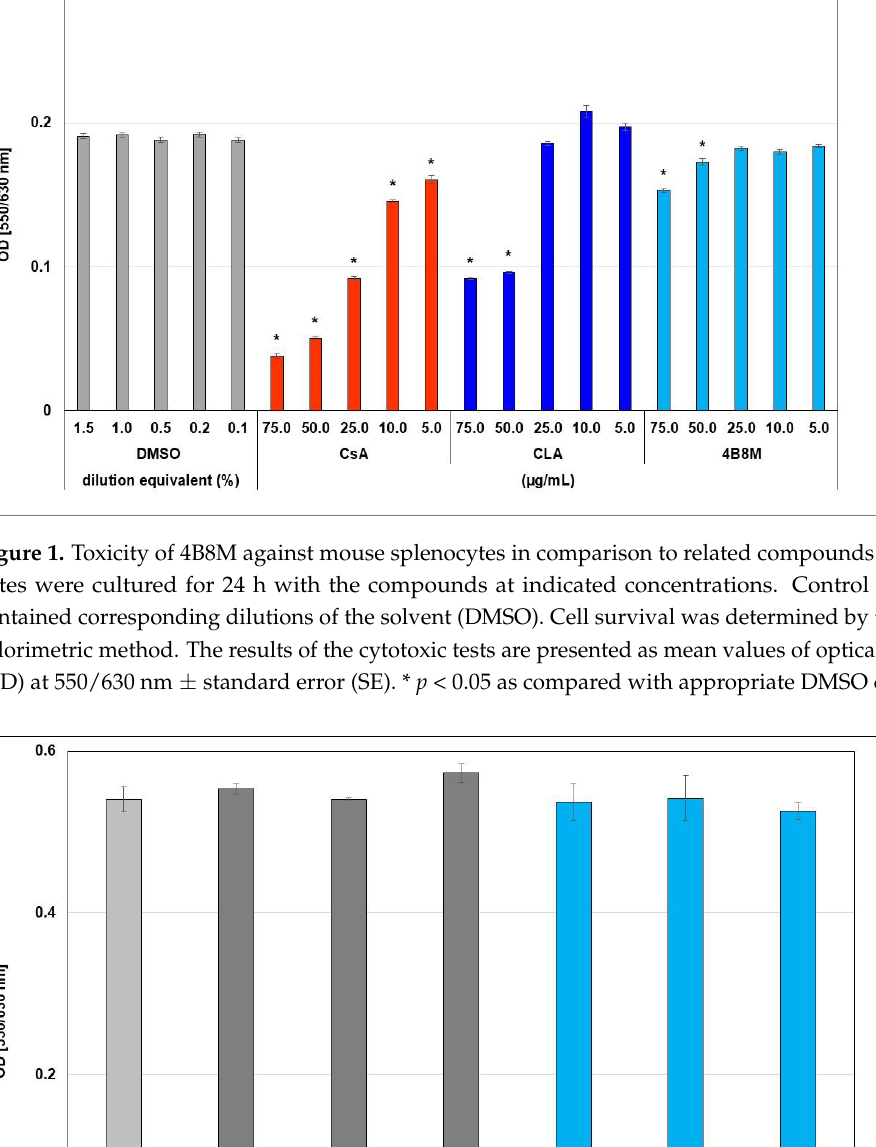
Figure 2. Cell toxicity of 4B8M against reference A-549 cell line. The test was performed in a monolayer culture of cell line A-549 that was incubated at a density of 5 × 10 4 /well for 72 h. 4B8M was tested at a 6–25 µ g/mL concentration range. Control cultures contained corresponding dilutions